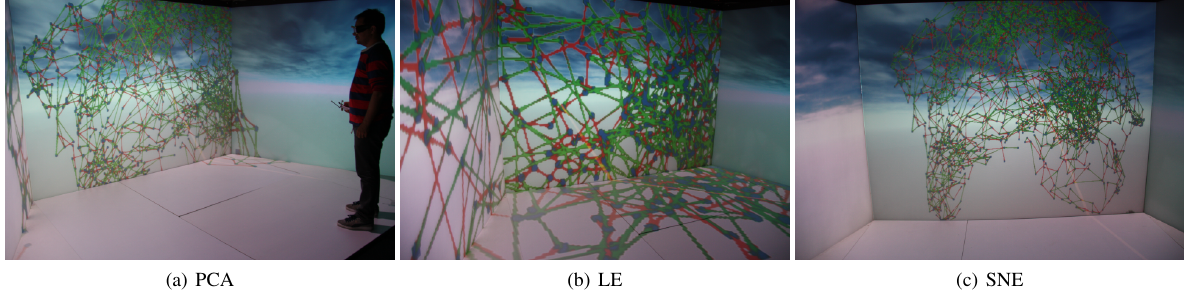
Figure 8: The immersive visualization of the MST of neighborhood graph of the face data points before and after dimension reduction. The green and red lines show the edges of trees before and after dimension reduction,